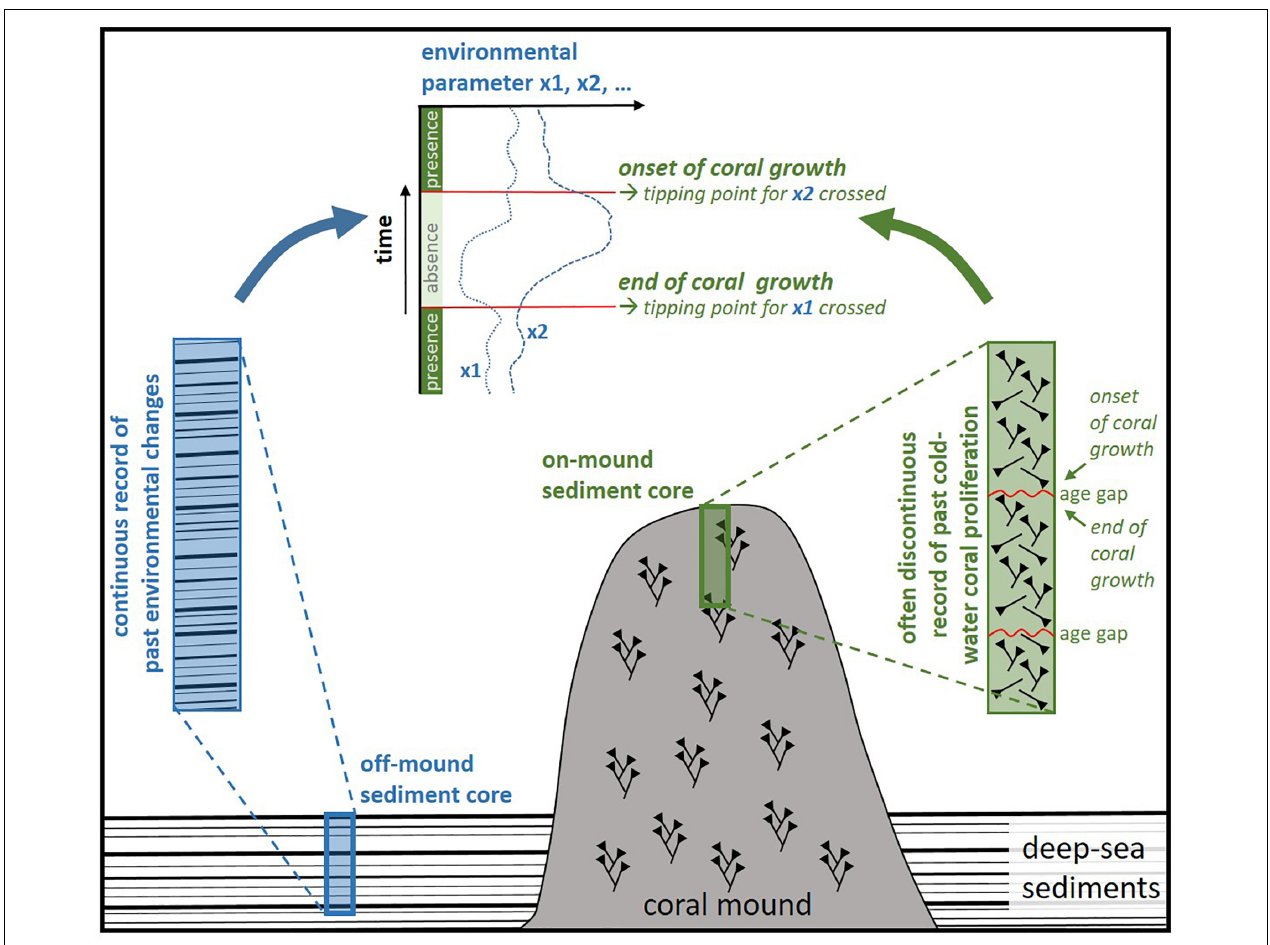
FIGURE 1 | Schematic presentation of the “geological approach” to assess the sensitivity of cold-water corals to environmental change and to identify the key ecological drivers being able to push CWC across tipping points causing the demise/return of entire populations. By combining cold-water coral records retrieved from coral mounds with continuous paleoenvironmental records, such key drivers can be